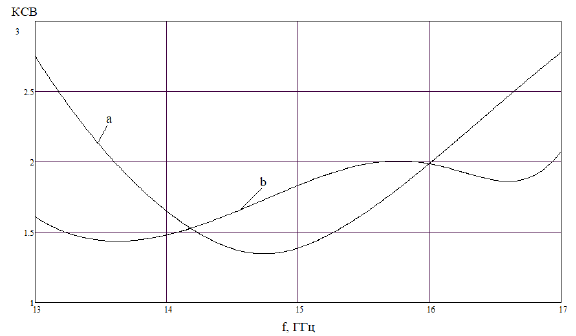
Fig. 2. Dependencies of the SWR on the frequency of printed emitters without spikes (a) and with spikes